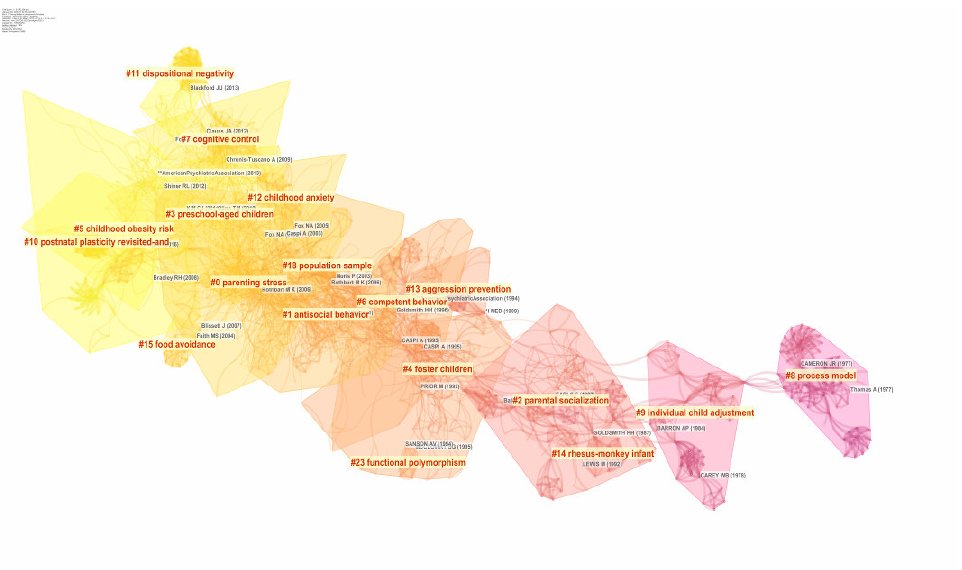
Figure 7. The Cluster Structure of Citations by